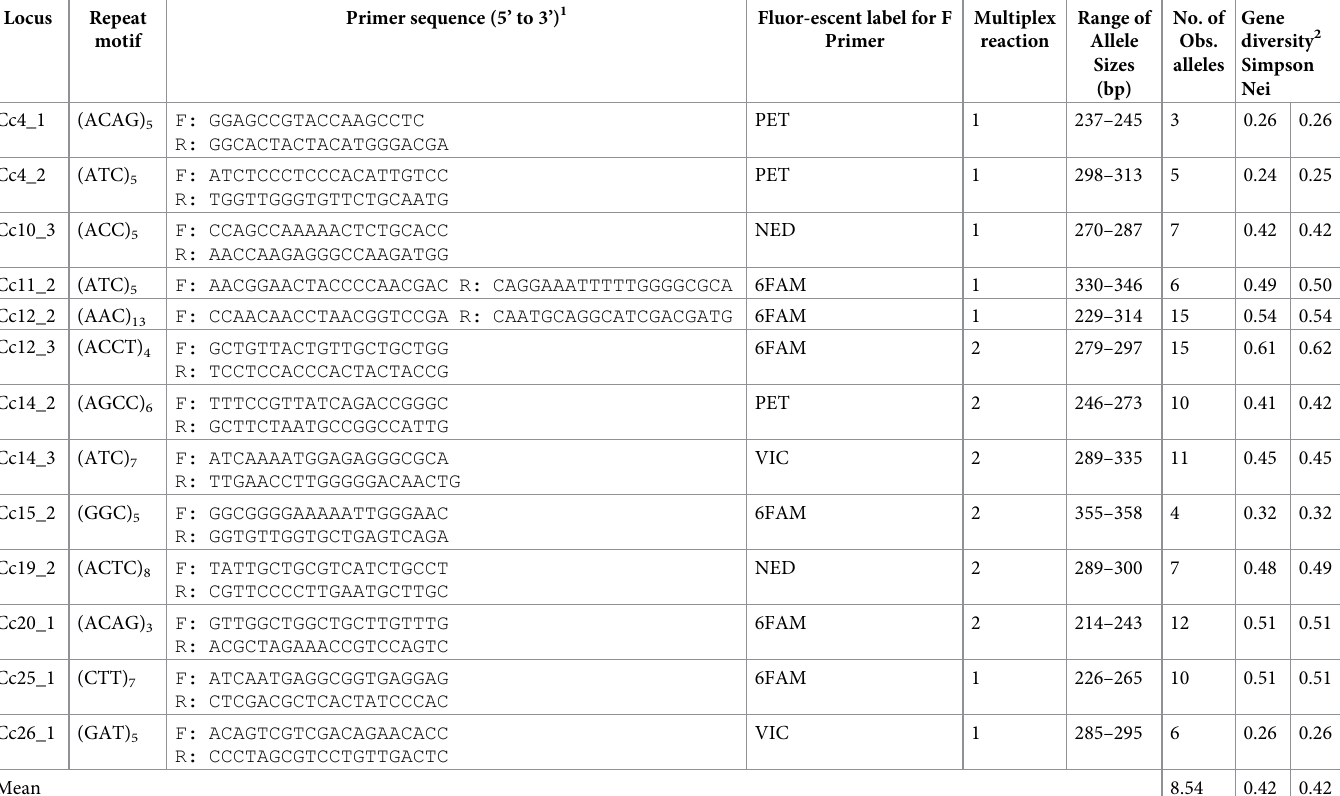
Table 2. Repeat unit, primer sequences, multiplexing primers and reactions, size and number of observed alleles, and estimated gene diversity for C . cassiicola microsatellite